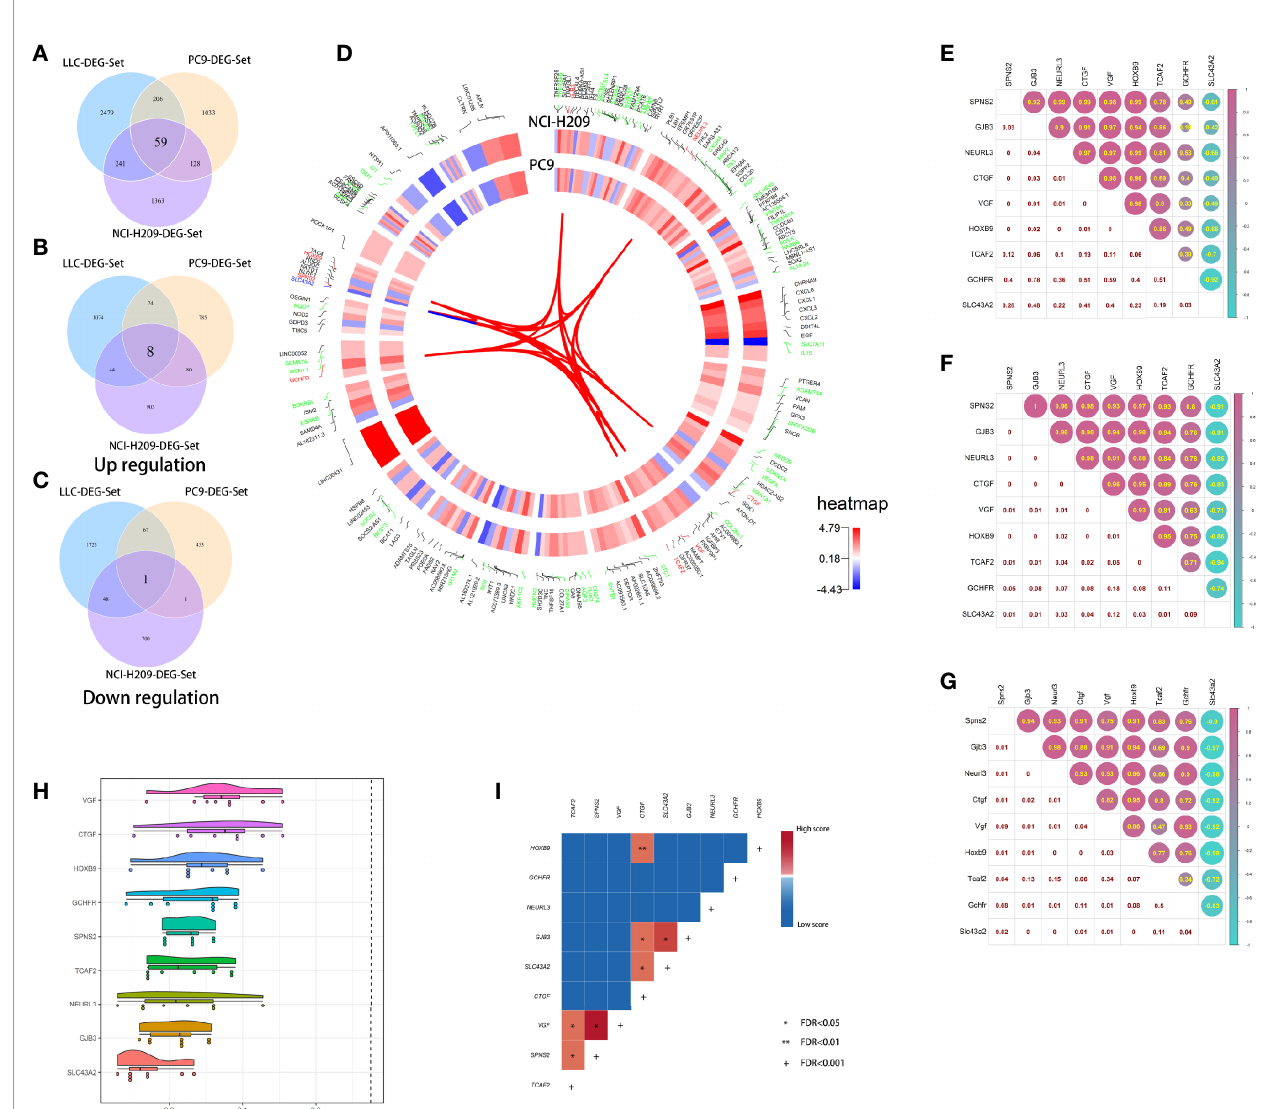
FIGURE 5 | Correlation analysis of the common DEGs. (A) The intersection of three DEG sets. (B) The eight common upregulated DEGs shared by three DEG sets. (C) The common downregulated DEG shared by three DEG sets. (D) The chromosome location of the common DEGs shared by both DEG sets of co-cultured NCI- H209 and brain metastatic PC9. (E) The expression correlation analysis of the nine common genes in the co-cultured NCI-H209 cells. (F) The expression correlation analysis of the nine common genes in the brain metastatic PC9 cells. (G) The expression correlation analysis of the nine common genes in the brain metastatic LLC cells. (H) Semantic similarity analysis of the nine common genes. (I) The protein-interaction coupling correlation analysis of the nine common genes, *FDR < 0.05, **FDR < 0.01, +FDR <